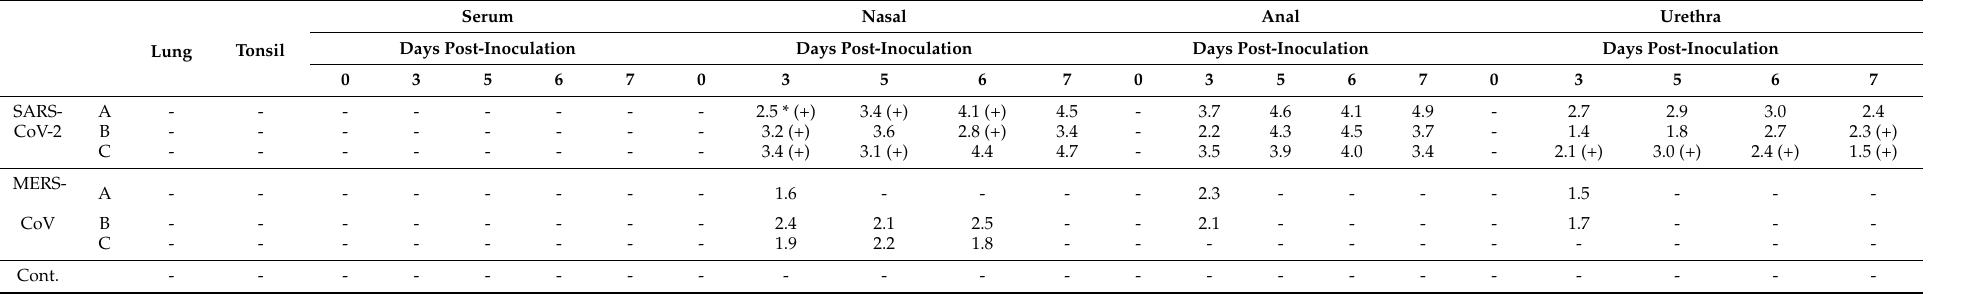
Table 1. Viral RNA detection by real-time PCR and virus cultivation of SARS-CoV-2 or MERS-CoV in tissue